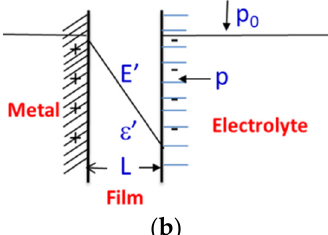
Figure 4. Interface between electrode surface and electrolyte: (a) SEM and (b) electrical double layer model of oxide film redrawn from [35]. Reproduced with permission from N. Sato, Vol. 16, 1683–1692, Electrochimica Acta; published by Elsevier, October 1971.